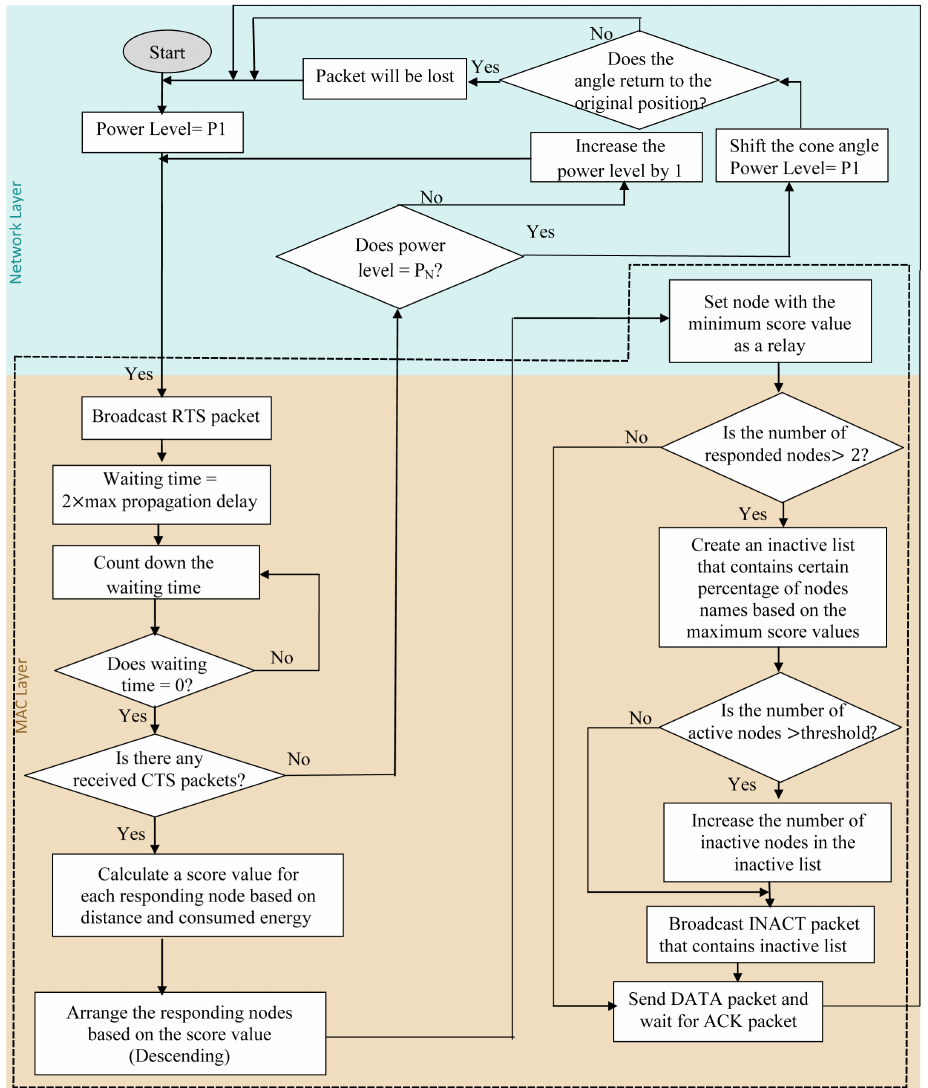
Figure 3. Flow chart of the proposed protocol from sender